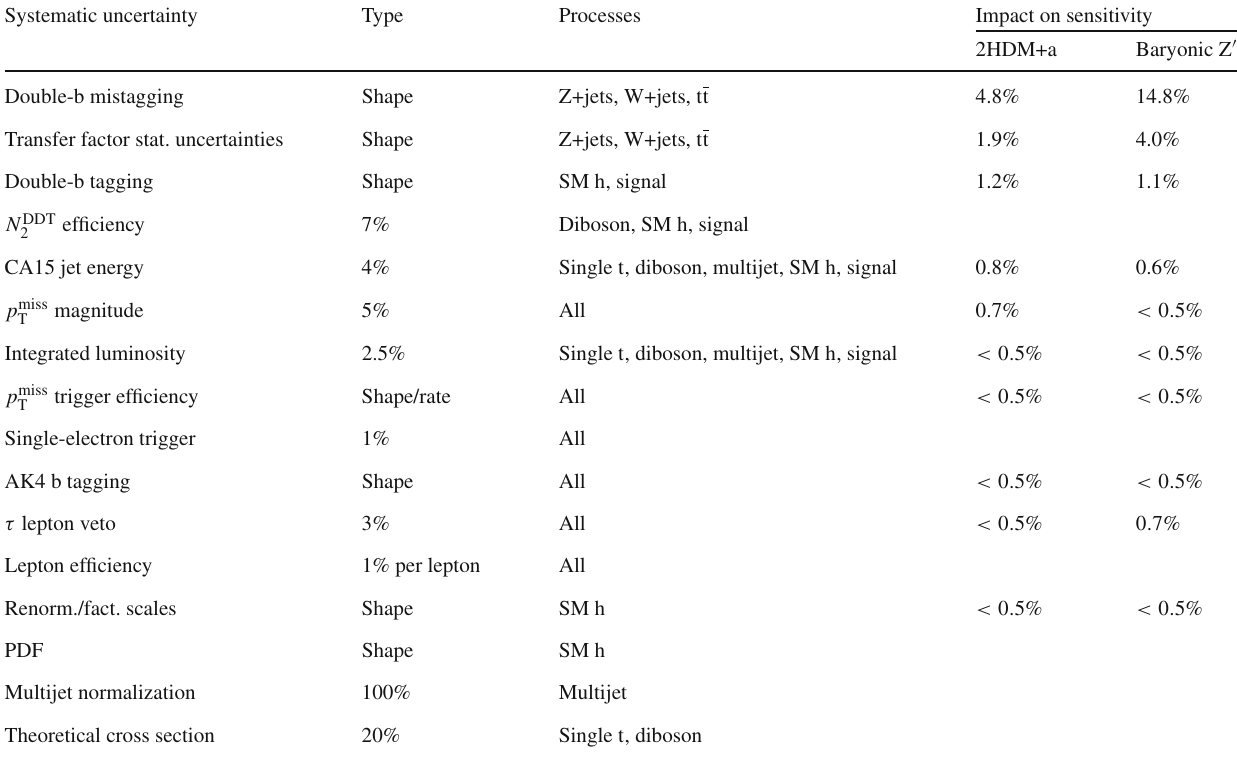
Table 2 Sources of systematic uncertainty, along with the type (rate/shape) of uncertainty and the affected processes. For the rate uncertainties, the percentage value of the prior is quoted. The last col- umn denotes the improvement in the expected limit when removing the